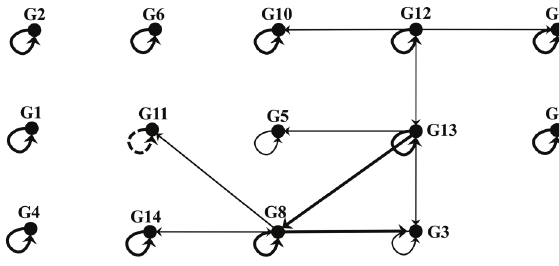
Fig. 6. Reduced graph